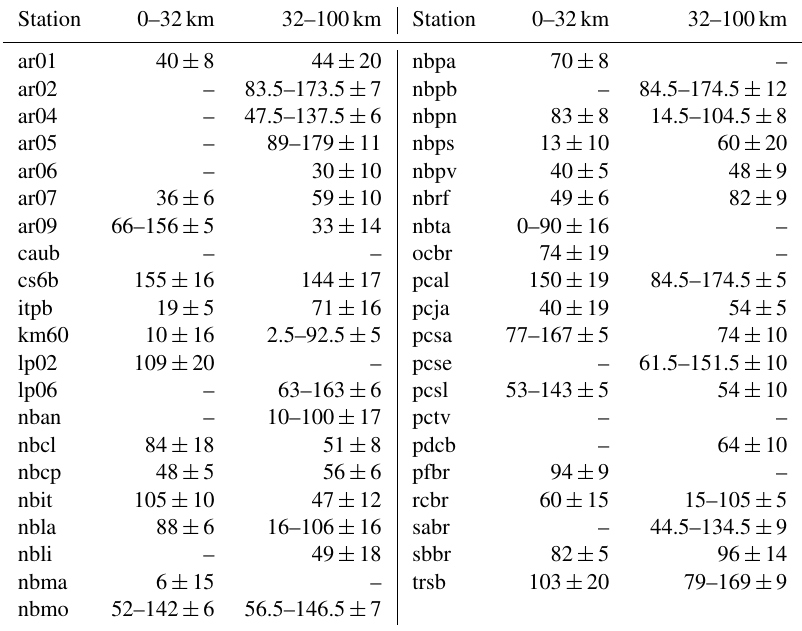
Table 1. Results of anisotropic symmetry directions for several depth ranges: 0–32, 32–100 and 0–100km. One direction corresponds to either the trend of the dip in the case of dipping interface or to the trend of the fast axis in the case of plunging anisotropy. When two directions are indicated, they refer to the fast axis and to its perpendicular direction (horizontal anisotropy). Uncertainties were estimated from bootstrap quantification (resampling 200 times at every